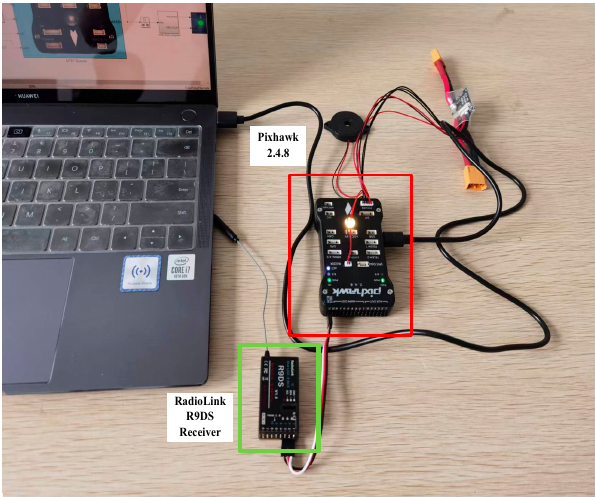
Figure 8. Hardware system connection.